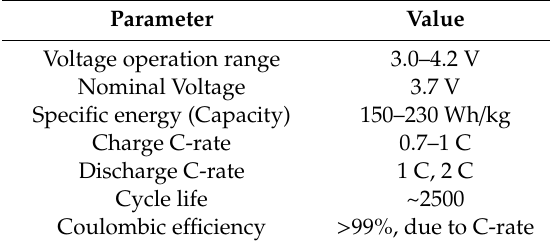
Table 3. Lithium nickel manganese cobalt (NMC) battery cell chemistry technical